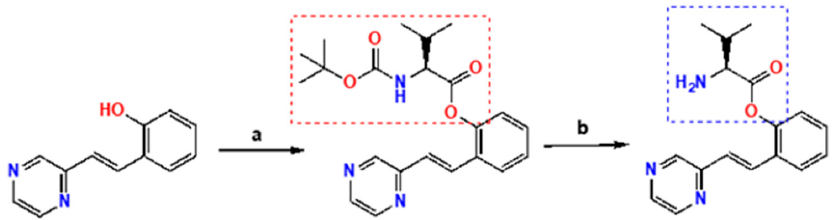
Figure 29. Reagents and conditions: ( a ) N-Boc-valine, HBTU, DIPEA, anhydrous acetonitrile, room temperature, 24 h ( b ) DCM, TFA, room temperature, 1 h.